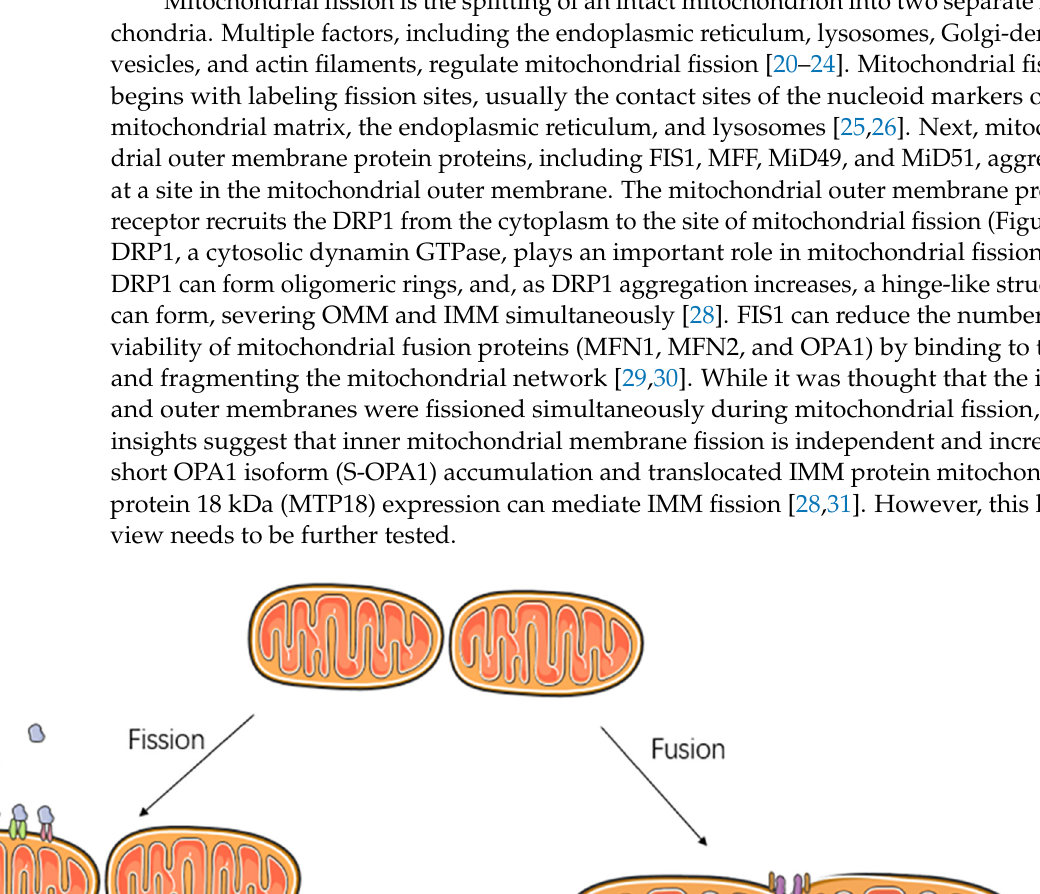
Figure 1. The structure of mitochondria. OMM: mitochondrial outer membrane. IMM: inner mito- chondrial membrane. Cristae: mitochondrial inner membrane is depressed inward to form cristae. Matrix: internal space wrapped by the inner mitochondrial membrane. IMS: the space between the outer mitochondrial membrane and the inner mitochondrial membrane.